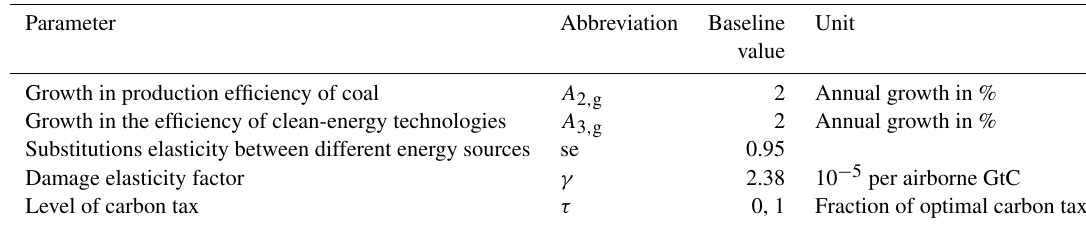
Table 1. Parameters in climate–economy model modified for scenarios. Parameter Growth in production efficiency of coal Growth in the efficiency of clean-energy technologies A 3 , g Substitutions elasticity between different energy